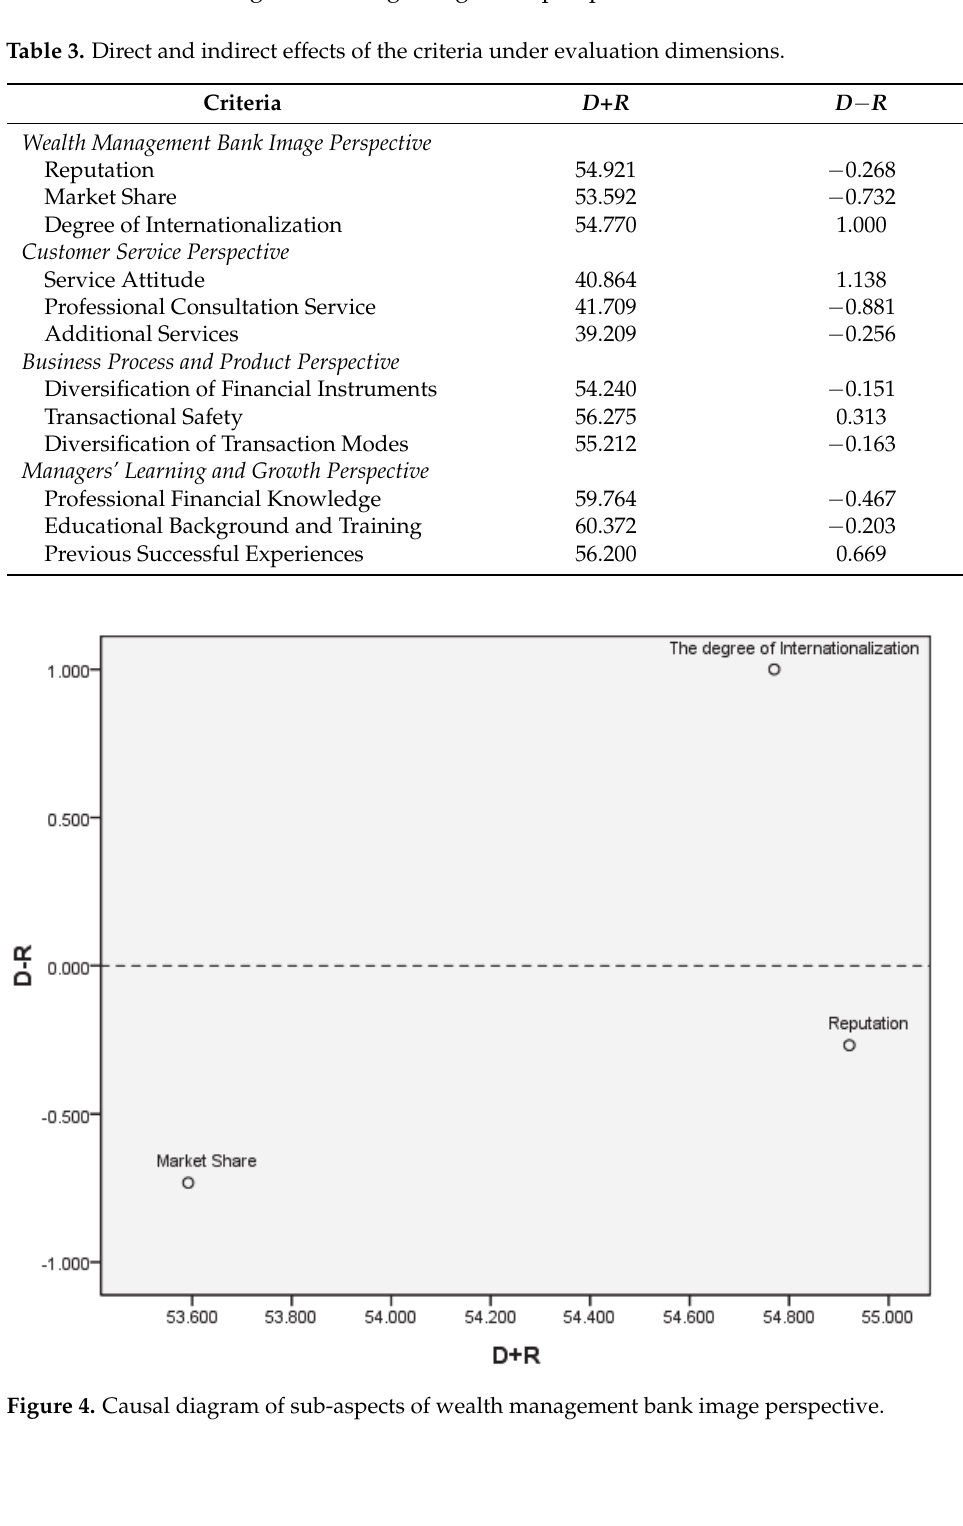
Figure 5. Causal diagram of sub ‐ aspects of customer service perspective criteria .